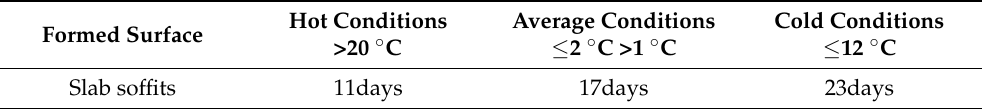
Table 4. Minimum Formwork Stripping Times for Slab